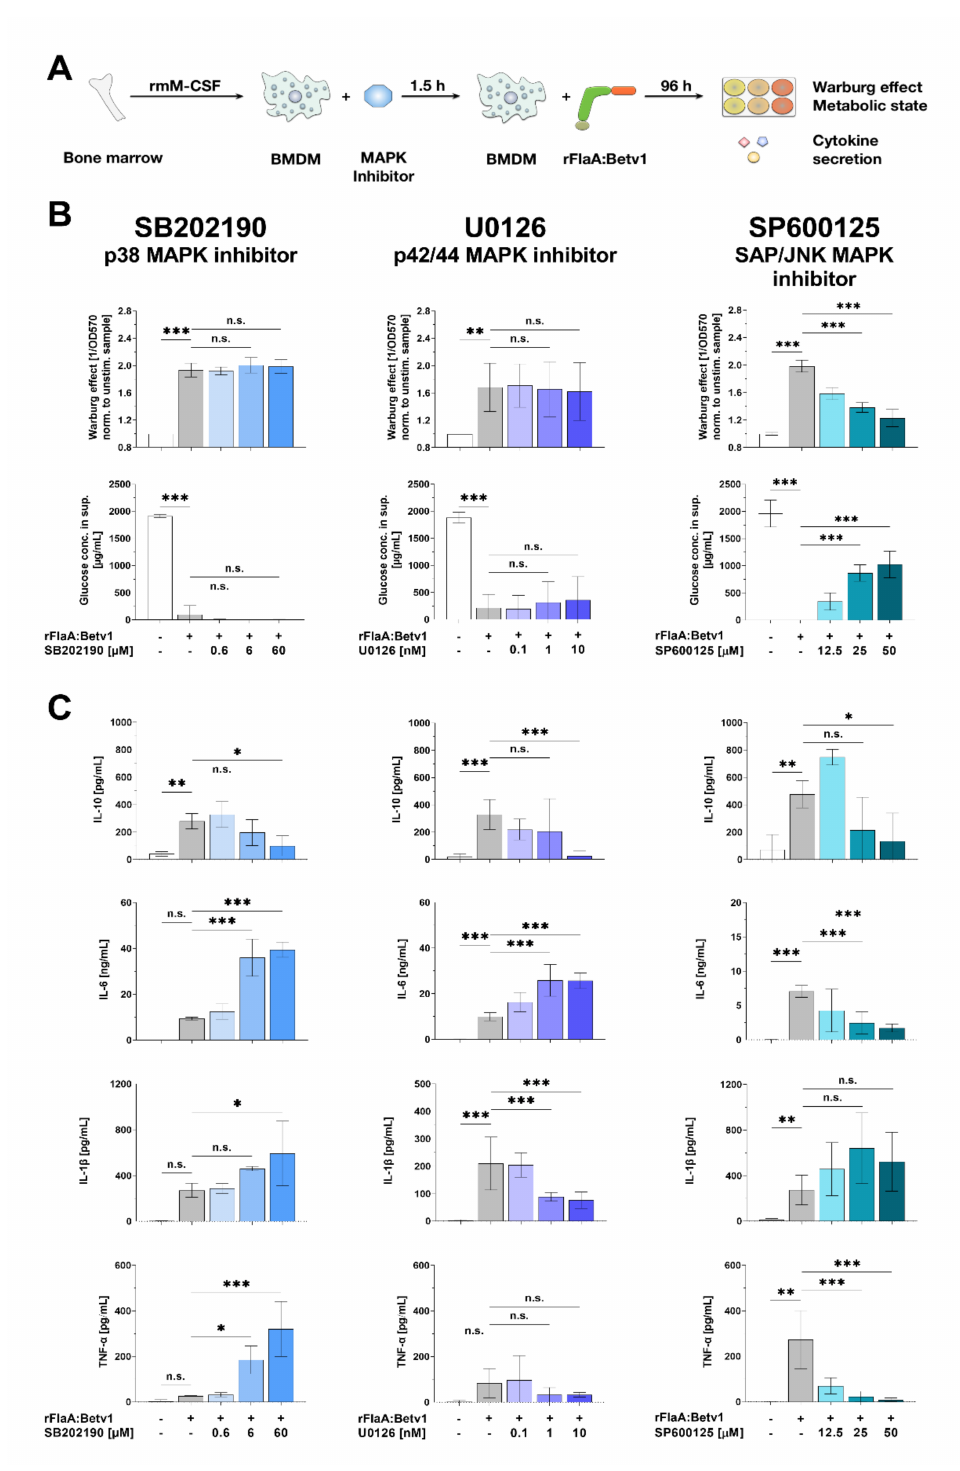
Figure 6. SAP/JNK MAP kinase signaling contributes to rFlaA:Betv1-induced activation of BMDM metabolism as well as both pro- and anti-inflammatory cytokine secretion. C57BL/6 BMDMs were differentiated from bone marrow, pre-treated with the indicated MAPK inhibitors (either SB202190 (p38 MAPK inhibitor), U0126 (p42/44 MAPK inhibitor), or SP600125 (SAP/JNK MAPK inhibitor)) for 90 min, and subsequently stimulated with rFlaA:Betv1 for additional 96 h ( A ). Cells were analyzed for their metabolic state ( B ) and cytokine secretion by ELISA ( C ). Data are mean results of three independent experiments ± SD, with two technical replicates per experiment. Statistical significance indicated as: n.s. p -value > 0.05, * p -value < 0.05, ** p -value < 0.01, *** p -value <